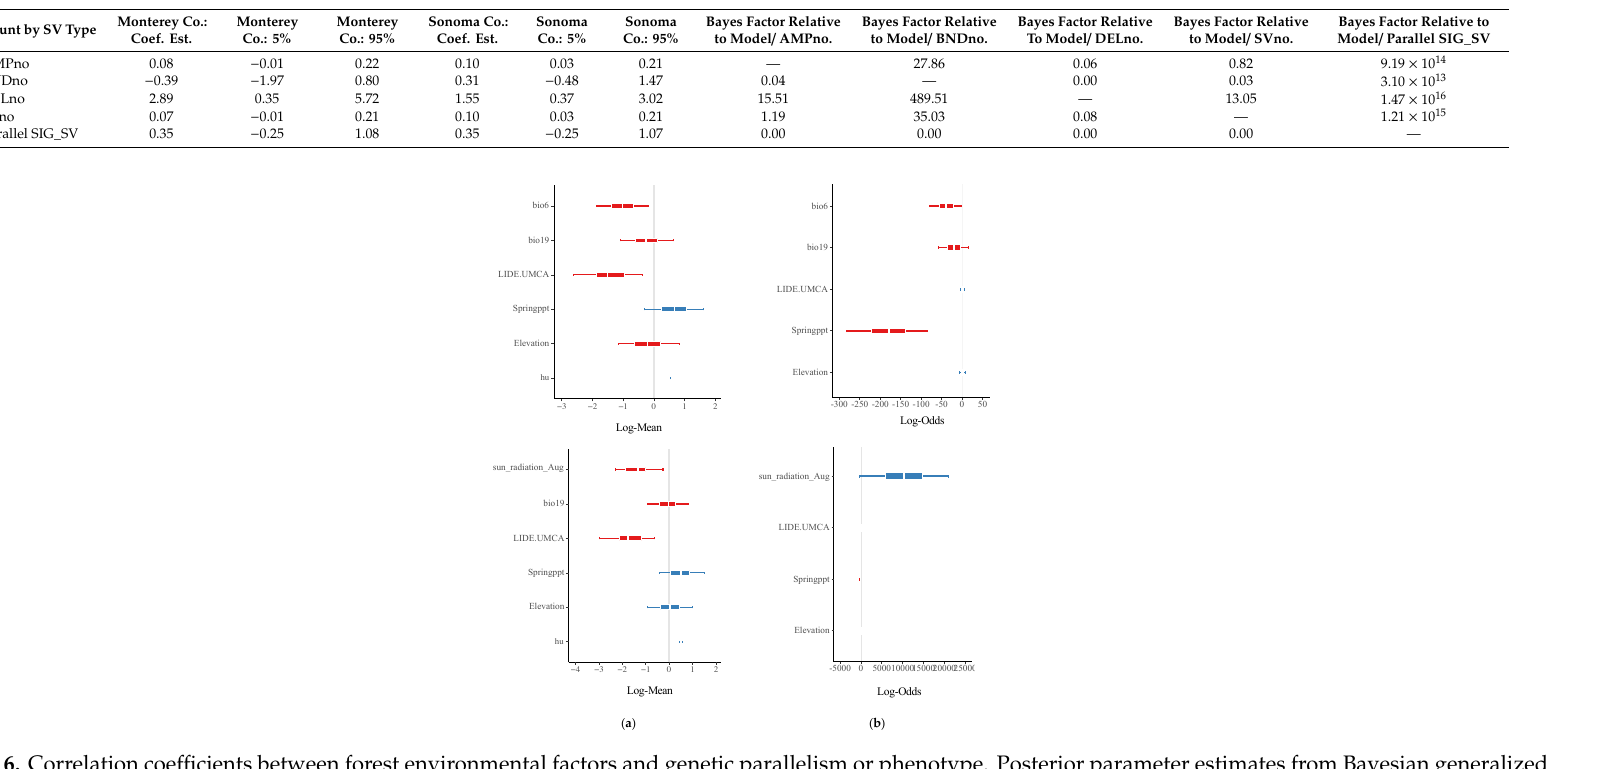
Figure 6. Correlation coefficients between forest environmental factors and genetic parallelism or phenotype. Posterior parameter estimates from Bayesian generalized linear hurdle Poisson models of parallel SVs in response to Jaccard’s distance of environmental factors ( a ). Posterior parameter estimates from a generalized linear model with a Bernoulli distribution (logit link function) of Jaccard’s distance between environmental conditions associated with NWT phenotype ( b ). Jaccard distance of environmental variables are calculated as the difference between Monterey Co. and Sonoma Co. First model (top panels) includes minimum temperature of the coldest month (bio 6), precipitation of the coldest quarter (bio19), N. densiflorus and U. californica stem density (LIDE.UMCA), precipitation during Spring (Springppt), Elevation, and a hurdle probability (hu). Second model (bottom panels) includes the same parameters, except solar radiation during August (sun radiation Aug) replaces minimum temperature during the coldest month. Bayes factor comparing both models was not significant (1.66). Model performance was validated using posterior predictive checks, and by inspection of the Markov chain trace plots. For all models, the observed response variable (“y”) was within the range of the simulated response variable (“y rep ”). The estimates of the coefficients converged, as shown in the Markov chain trace plots (Figure S3) supporting model adequacy. Models associating genotype with phenotype were ranked according to their performance in comparison to all other models. Deletions showed the strongest correlation, while translocation and parallel SVs were the worst.